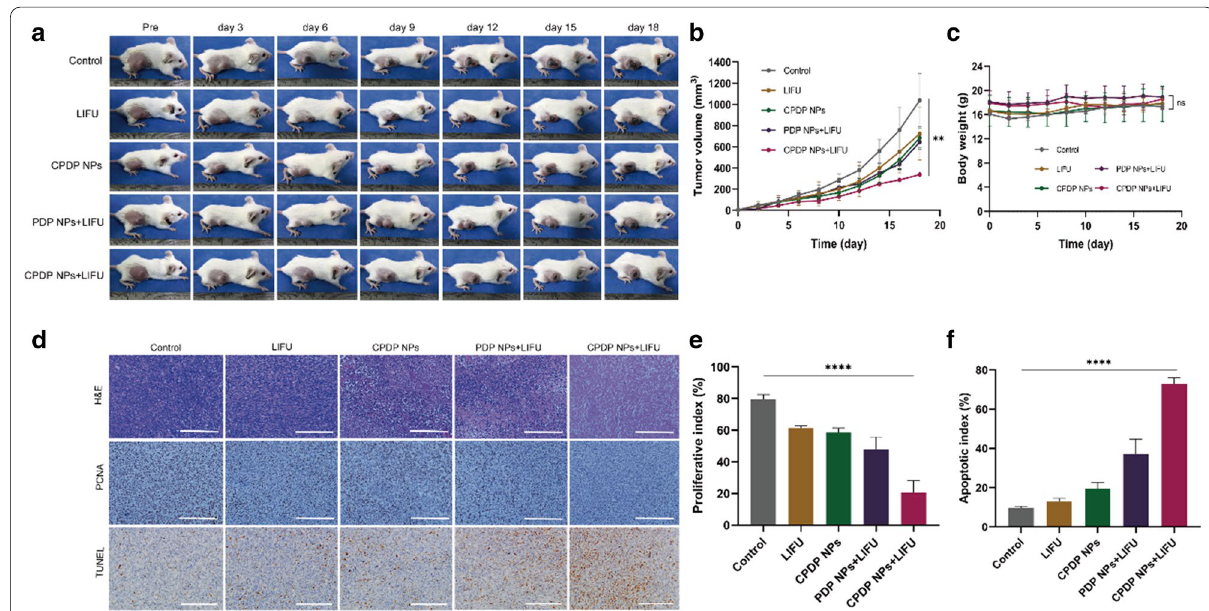
Fig. 8 a Images of tumor-bearing mice under various treatments within the certain 18 days ( n treatments (** p < 0.01). c Weights of tumor-bearing mice under various treatments ( ns no significance, n various treatments (scale bar: 200 μm). e Analysis of PCNA proliferation index of tumors under various treatments. f Analysis of TUNEL apoptotic index of tumors under various treatments (**** p < 0.0001, n